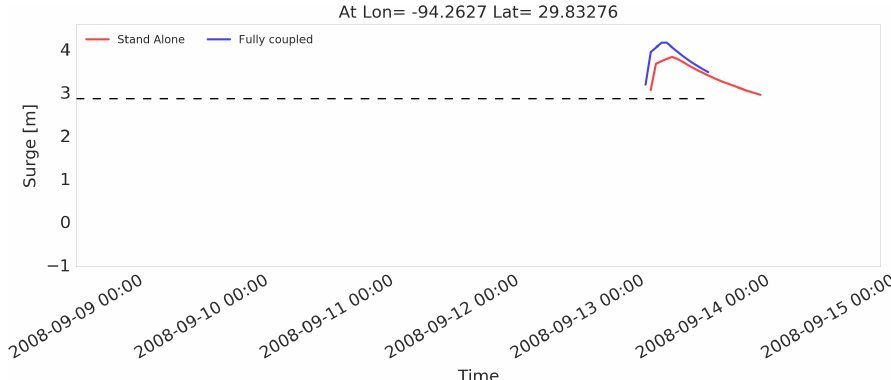
Figure 7. Time series of the total water level at the test point (locations shown in Figure 6). Black dahsed-line is the ground level. All model configurations and results are pre-decisional and for official use